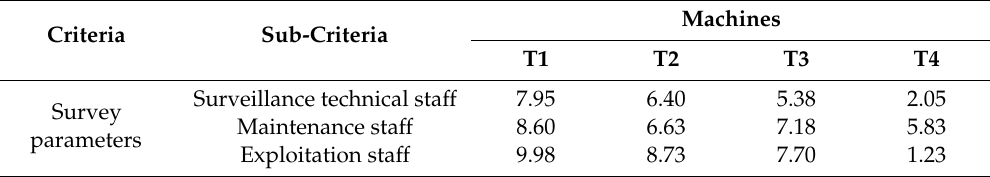
Table 13. Input parameters for applying the AHP method for survey parameters.